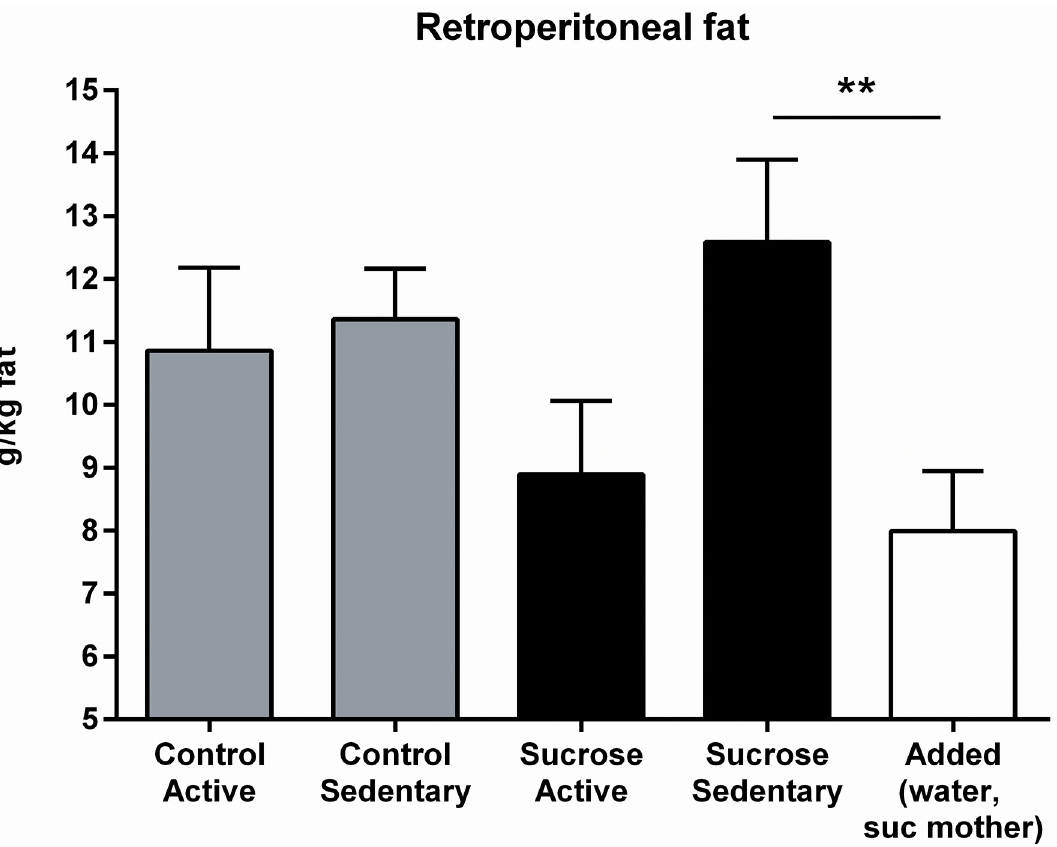
Fig 9. Retroperitoneal fat in Stage 3. Fat pad mass did not differ between the four experimental groups, but was lower in the Added group than in the Sucrose-Sedentary